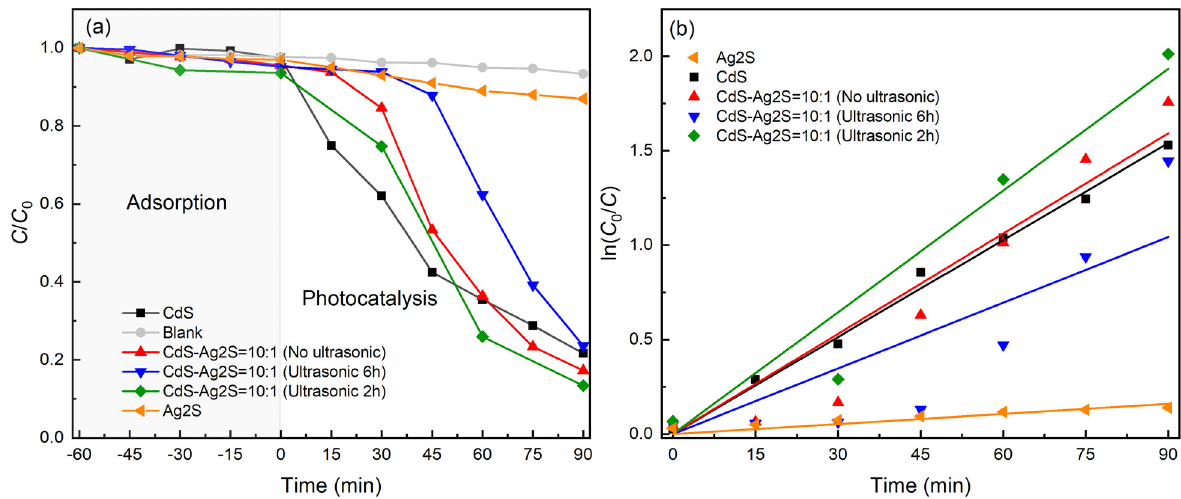
Figure 9: Time - course variation of C / C 0 toward MO: ( a ) C / C 0 vs time; ( b ) ln ( C 0 / C ) vs time.